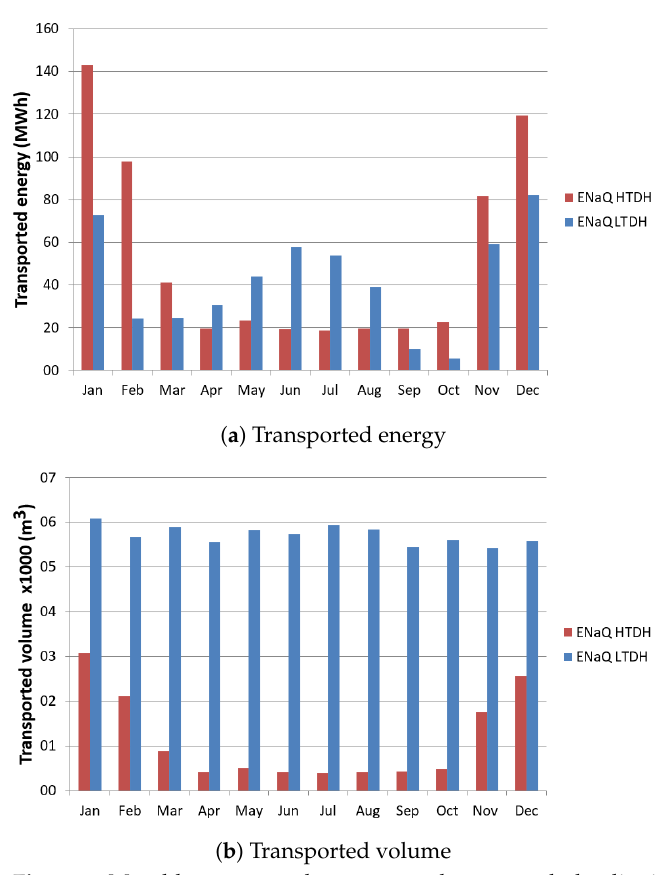
Figure 8. Monthly energy and transport volume trough the district network for ENaQ.